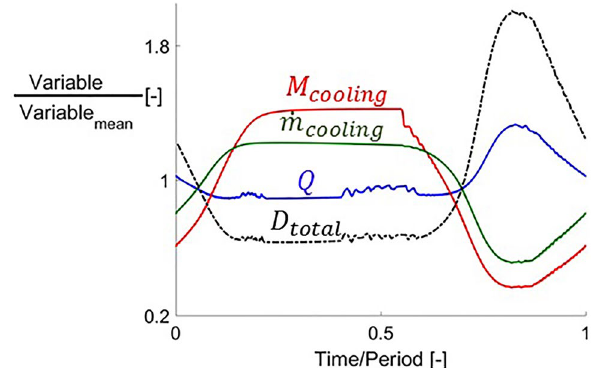
Figure 19. Thermal load and total drag evolutions with respect to time together with cooling mass flow and injection Mach